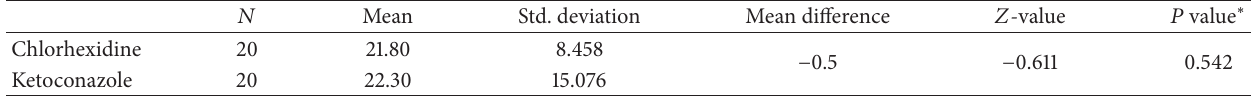
Table 2: Comparison of zone of inhibition between CHX and ketoconazole.